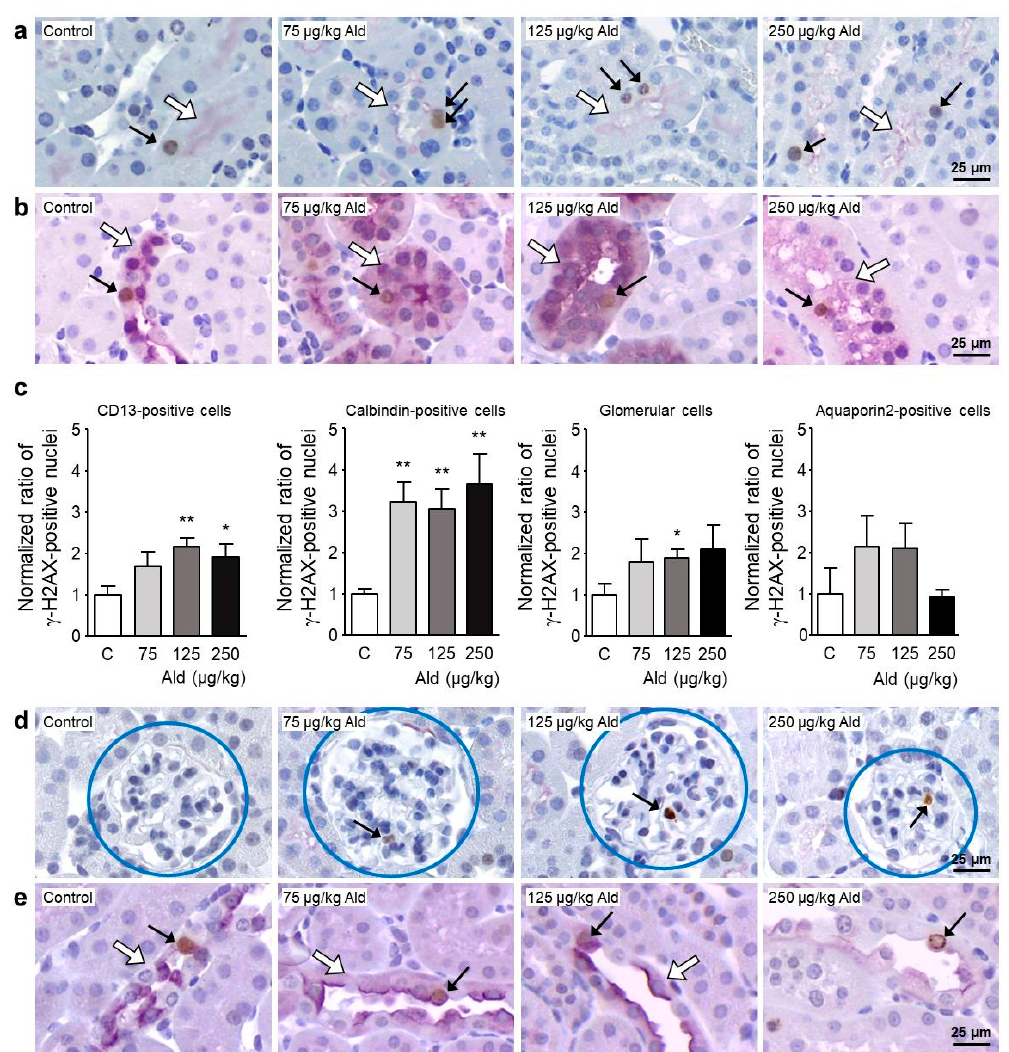
Figure 5. Localization of DNA damage caused by aldosterone infusion. ( a , b , d , e ) Representative images of those used for the localization of γ -H2AX in kidney cells. Double staining on paraffin-embedded kidney sections was carried out using antibodies against γ -H2AX (brown staining) and against cell-specific antigens (purple staining; ( a ) CD13, a marker specific for proximal tubule cells, located in the brush border; ( b ) calbindin, a marker specific for distal tubule cells and upper collecting duct cells, located in the cytosol; ( d ) glomeruli were identified due to their unique structure highlighted by the blue circles; ( e ) aquaporin 2, a marker for collecting duct cells and late distal tubular cells). Examples of γ H2AX-positive stained nuclei are marked with black arrows, the staining specific for the kidney cell type is indicated with a white arrow. ( c ) Quantification of γ -H2AX-positive nuclei in the four kidney structures related to the number of nuclei in purple stained structures in 10 visual fields. For the quantification in the glomerulus, 50 glomeruli were evaluated. γ -H2AX: phosphorylated histone 2AX, Ald: aldosterone. Data are shown as mean + SEM, n = 5. * p ≤ 0.05, ** p < 0.01 vs. C: control group.